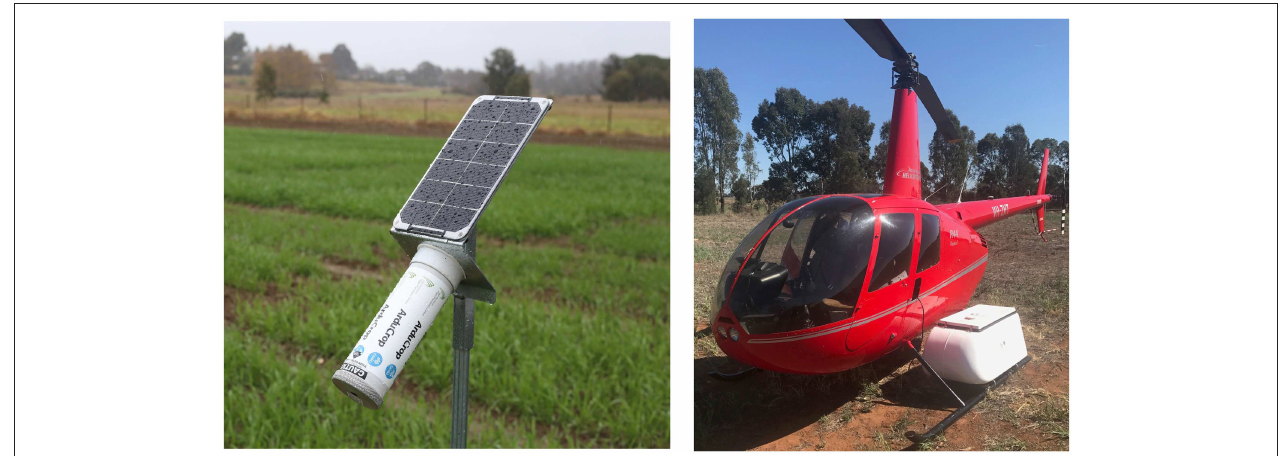
FIGURE 1 | ArduCrop wireless infra-red canopy temperature sensor (Left) and manned helicopter for airborne canopy temperature (Right) comprising white cargo pod mounted on skid of helicopter with thermal camera inside.